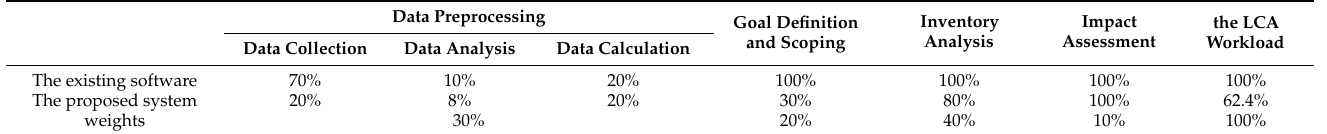
Table 5. Comparison of the LCA